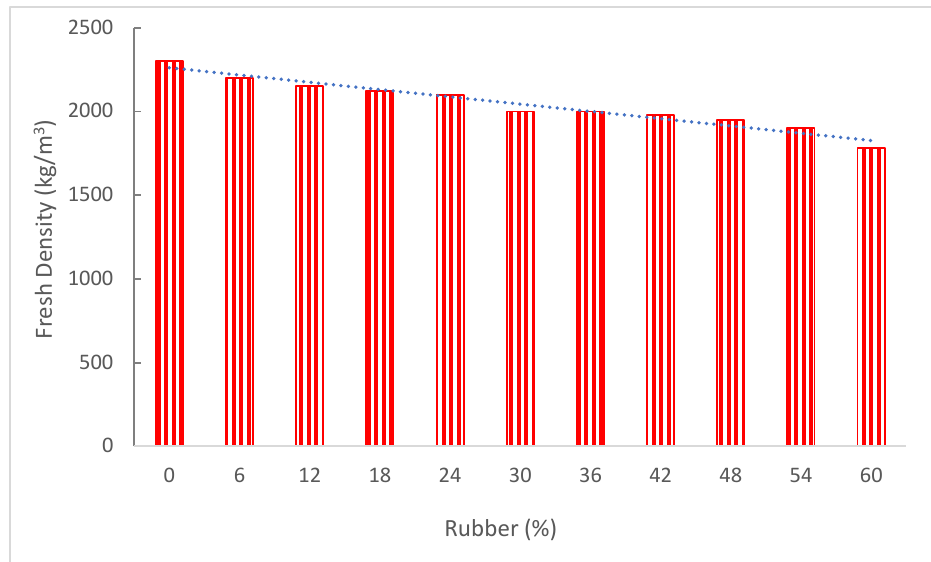
Figure 6. Fresh density of concrete: data source [34].